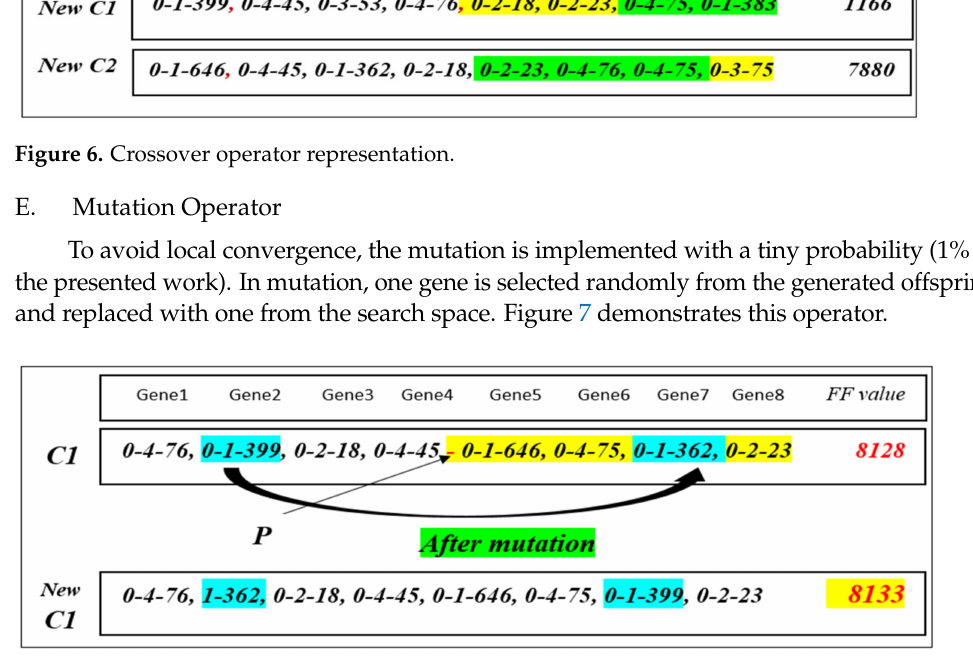
Figure 7. Mutation operator